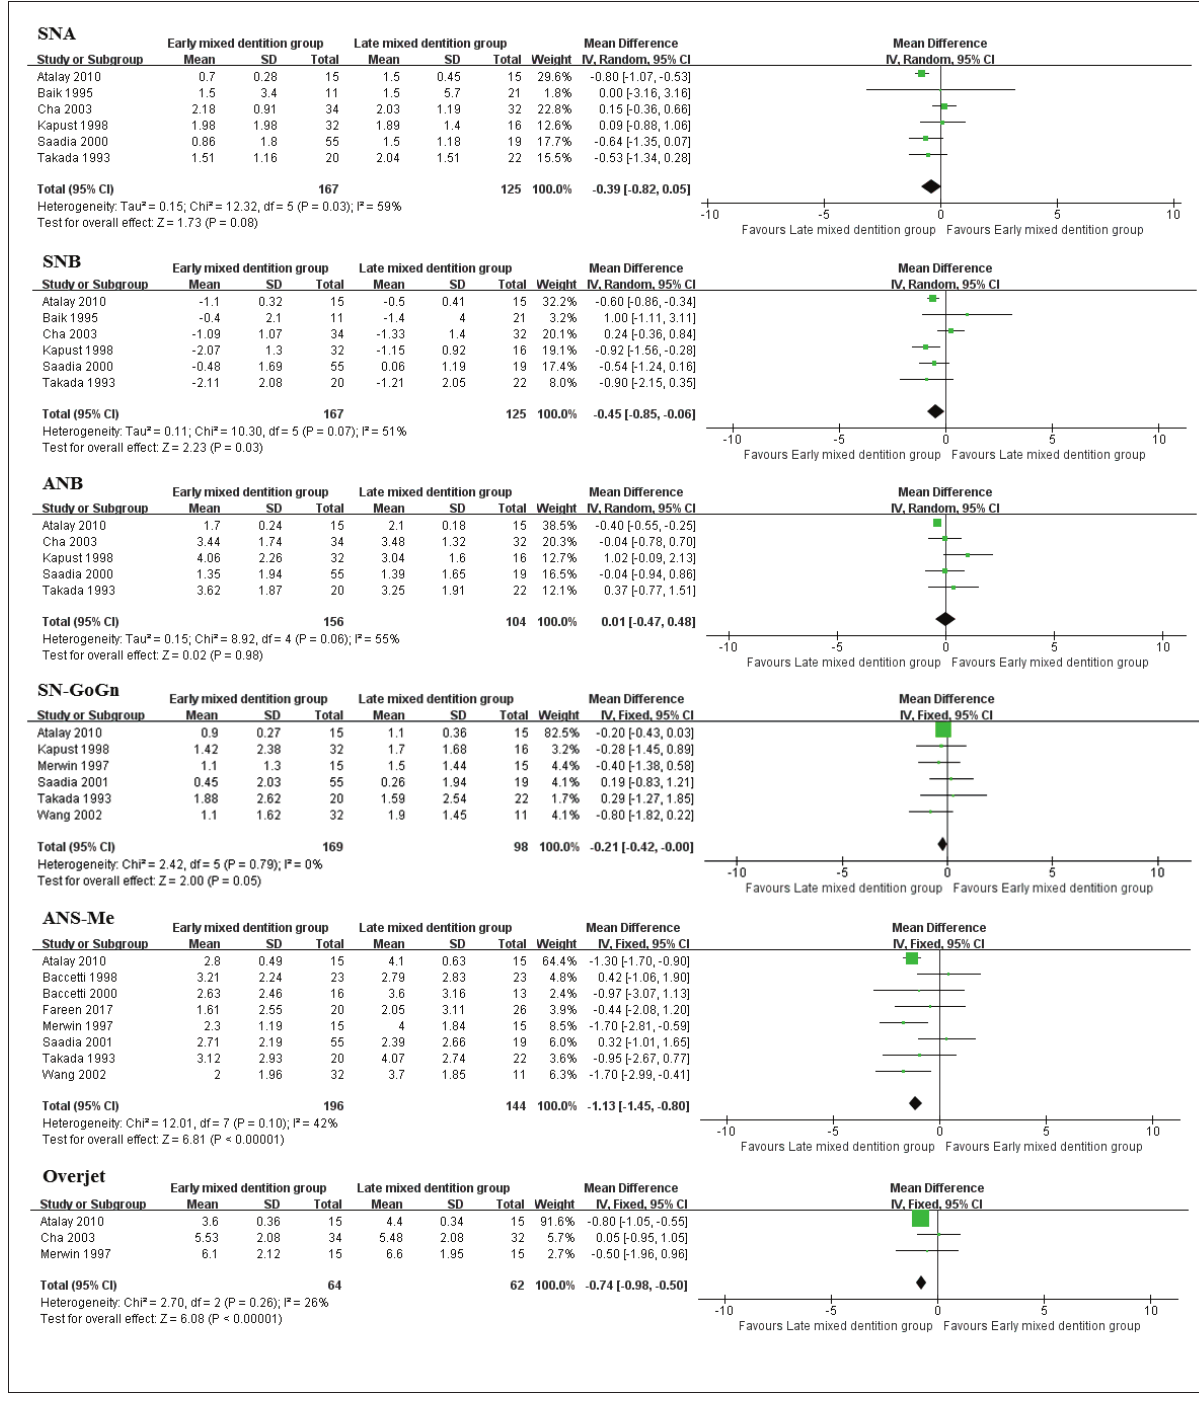
Figure 3. Meta-analysis between early mixed dentition and late mixed